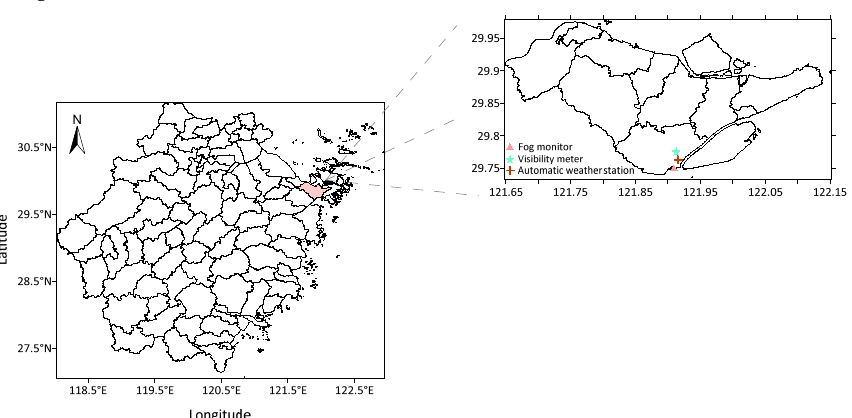
Figure 2. Distribution map of instruments and the automatic weather station. The map on the left is Zhejiang Province, China. The pink part is the Beilun District.